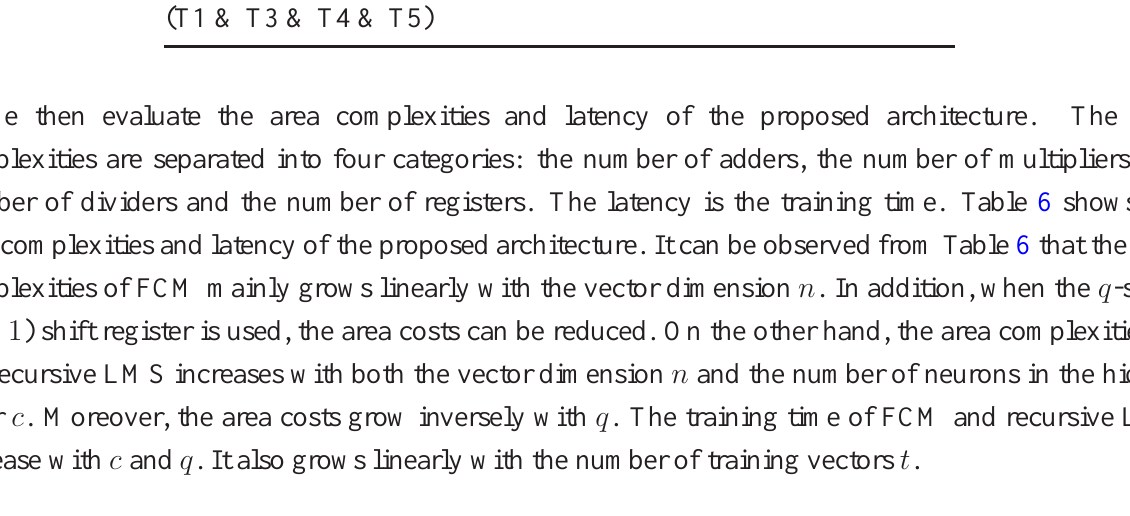
Table 6. The area complexities and latency of the proposed